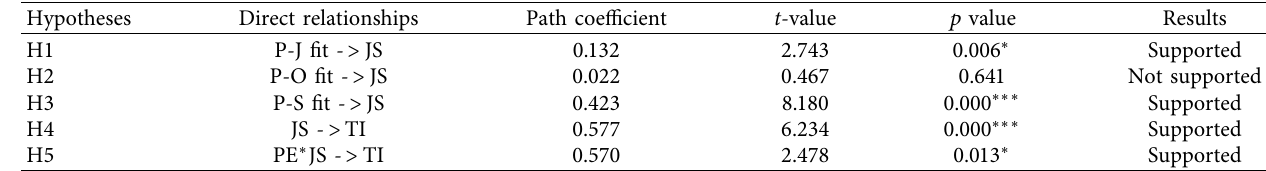
Table 5: Path coefficients and hypotheses testing.